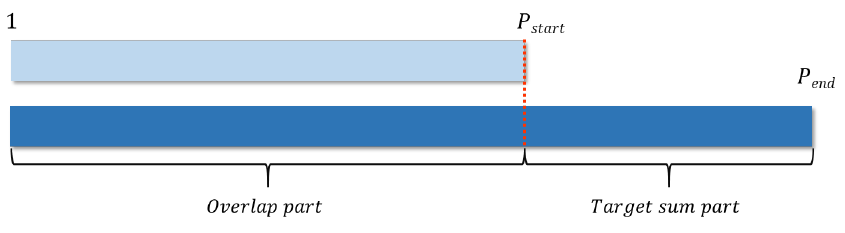
Figure 3. Diagram of summation of subsequence from P start to P end